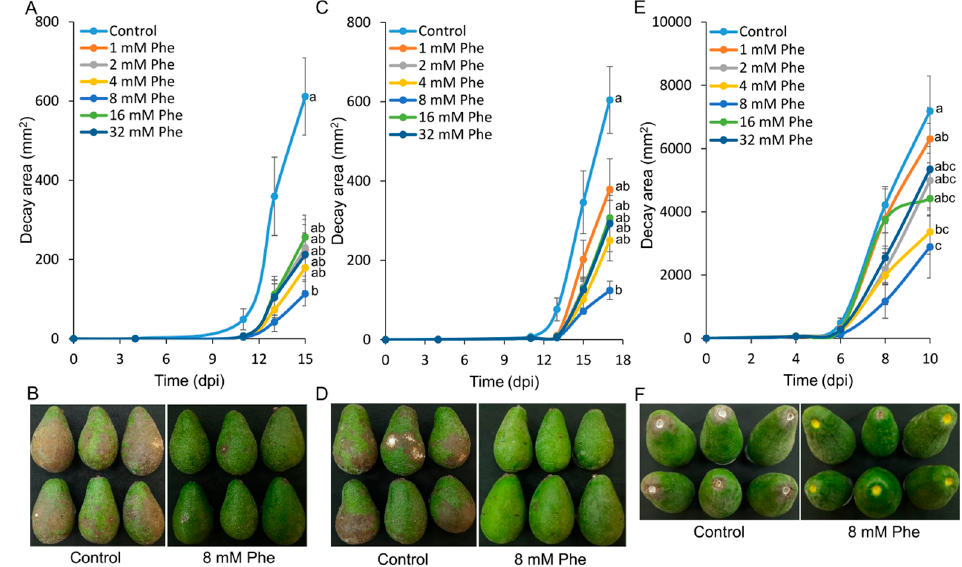
Figure 2. Effect of postharvest treatment with phenylalanine (Phe) on decay caused by C. gloeosporioides , A. alternata , or L. theobromae in avocado fruit. “Fuerte” avocado fruits were treated with different concentrations of Phe (1, 2, 4, 8, 16, or 32 mM) or water (control) and, 2 days later, inoculated with C. gloeosporioides , A. alternata , or L. theobromae. ( A ) Area of anthracnose decay caused by C. gloeosporioides . ( B ) Representative picture of avocado fruits treated with 8 mM Phe and controls, 13 days post inoculation (dpi). ( C ) Area of decay caused by A. alternata. ( D ) Representative picture of avocado fruits treated with 8 mM Phe and controls, 15 dpi. ( E ) Area of stem-end rot caused by L. theobromae . ( F ) Representative picture of avocado fruits treated with 8 mM Phe and controls, 8 dpi. Values are mean ± SE. Different letters indicate a significant difference between treatments according to one-way ANOVA, p ≤ 0.05.